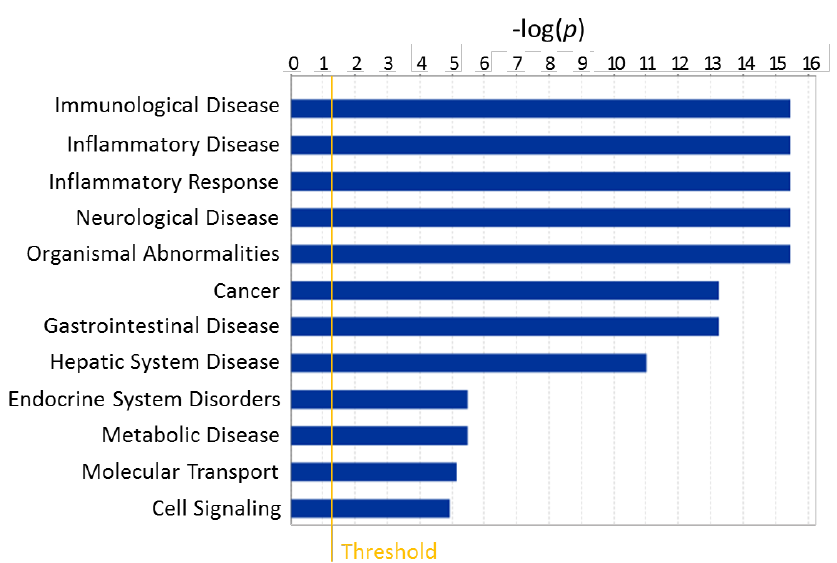
Figure 6. Diseases and functions most affected by onset of T1D in NOD mice using blood data of 524 metabolites measured at 26 weeks of age [28], as identified here by a corresponding enrichment analysis (Ingenuity Pathway Analysis).